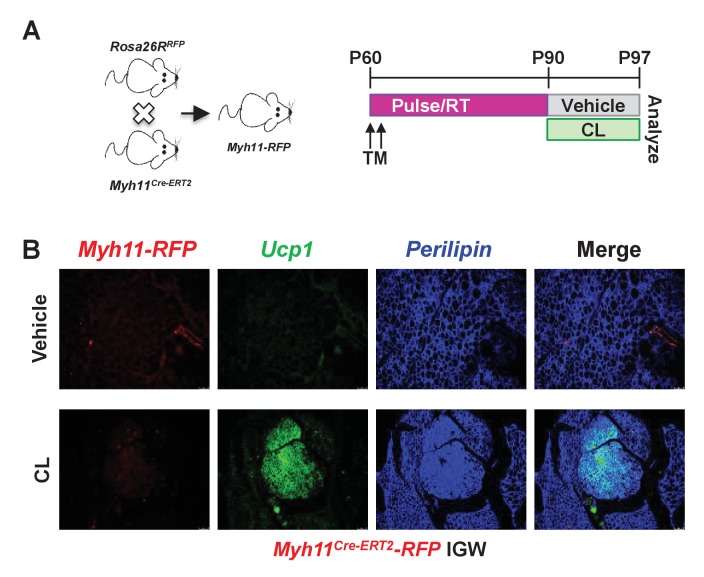
Myh11+ smooth muscle cells are not a source of Adrb3 induced beiging.(A) Illustration of mice and experimental regime: two-month-old Myh11Cre-ERT2; RosaR26RFP male mice were administered one dose of TM for two consecutive days. 30 days post TM, mice were randomized to vehicle or CL for seven days (n= 6/group). (B) Representative images of fate mapping analysis of Myh11Cre-ERT2-RFP+ cells into Ucp1 [Ucp1 (green) and Perilipin (blue)] beige adipocytes within IGW depots from mice described in (A) Scale bar = 100 µm.